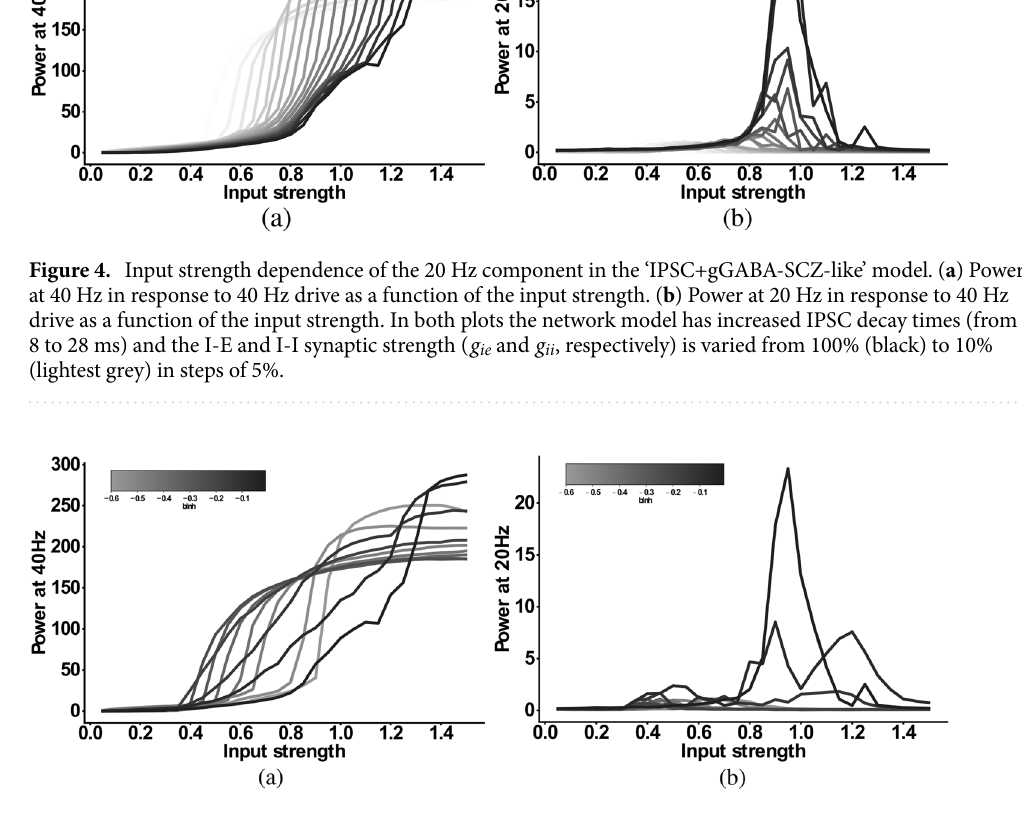
Figure 5. Input strength dependence of the 20 Hz component ‘IPSC+bInh-SCZ-like’ model. ( a ) Power at 40 Hz in response to 40 Hz drive as a function of the input strength. ( b ) Power at 20 Hz in response to 40 Hz drive as a function of the input strength. In both plots the network model has increased IPSC decay times (from 8 to 28 ms) and the interneuron excitability b inh is varied from − 0.01 (black) to − 0.1 (darkest grey) and then in steps of − 0.05 to − 0.6 (lightest grey).